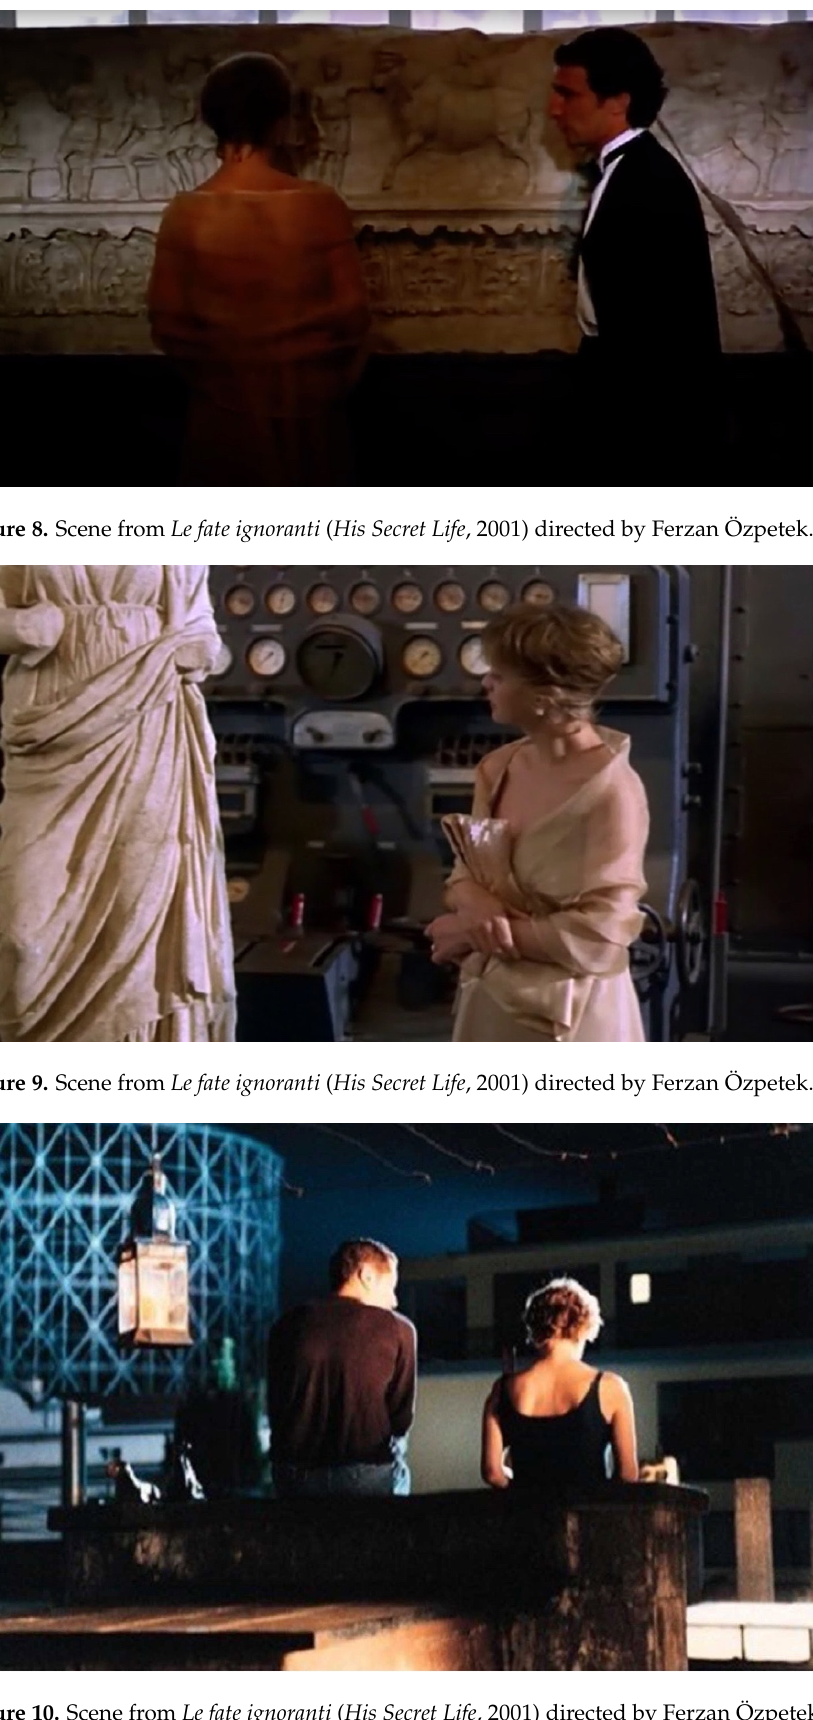
Figure 10. Scene from Le fate ignoranti ( His Secret Life , 2001) directed by Ferzan